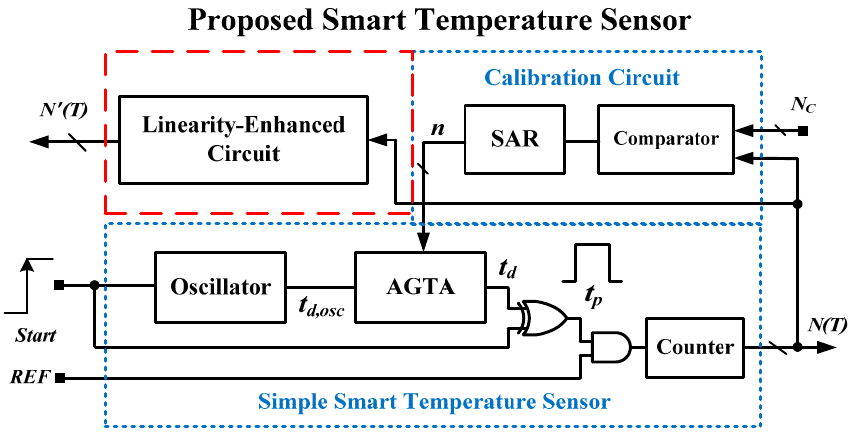
Figure 4. Architecture of the proposed all-digital smart temperature sensor.